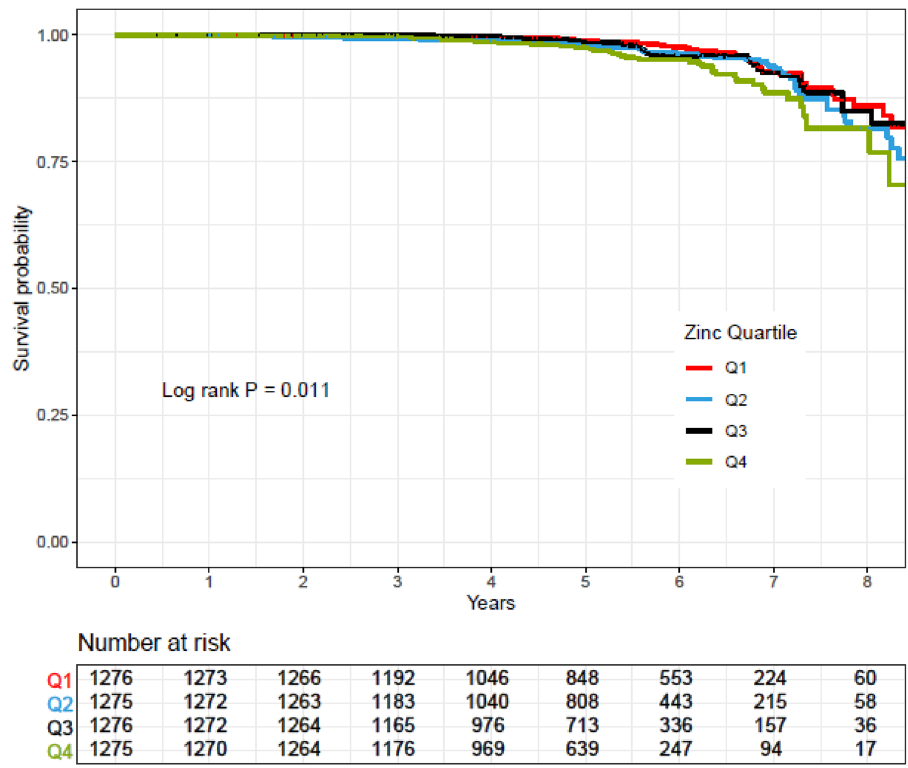
Figure 5. Kaplan–Meier estimates of CVD-free survival according to quartiles of zinc intake. P values by log- rank test and number of CVD outcomes recorded in the groups categorized by zinc